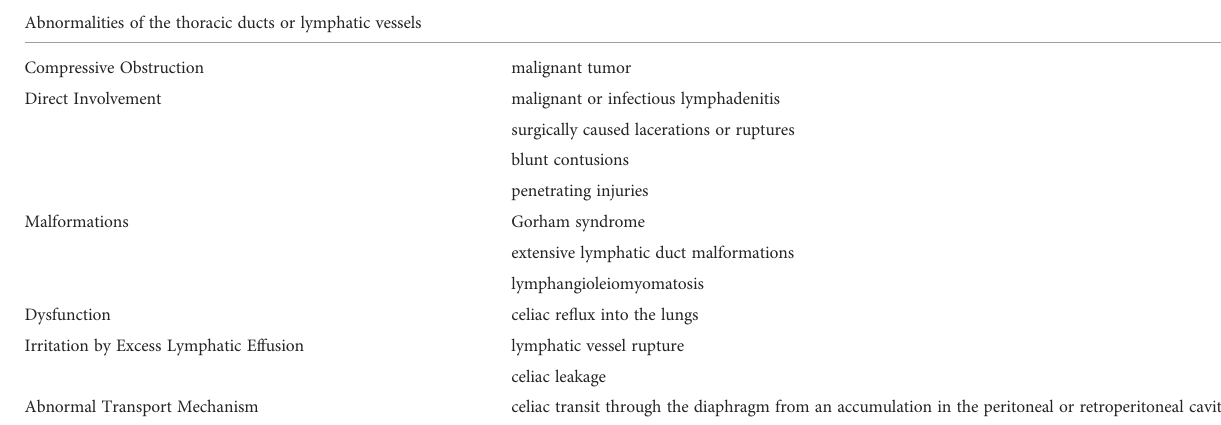
Table 1. The Pathogenesis of